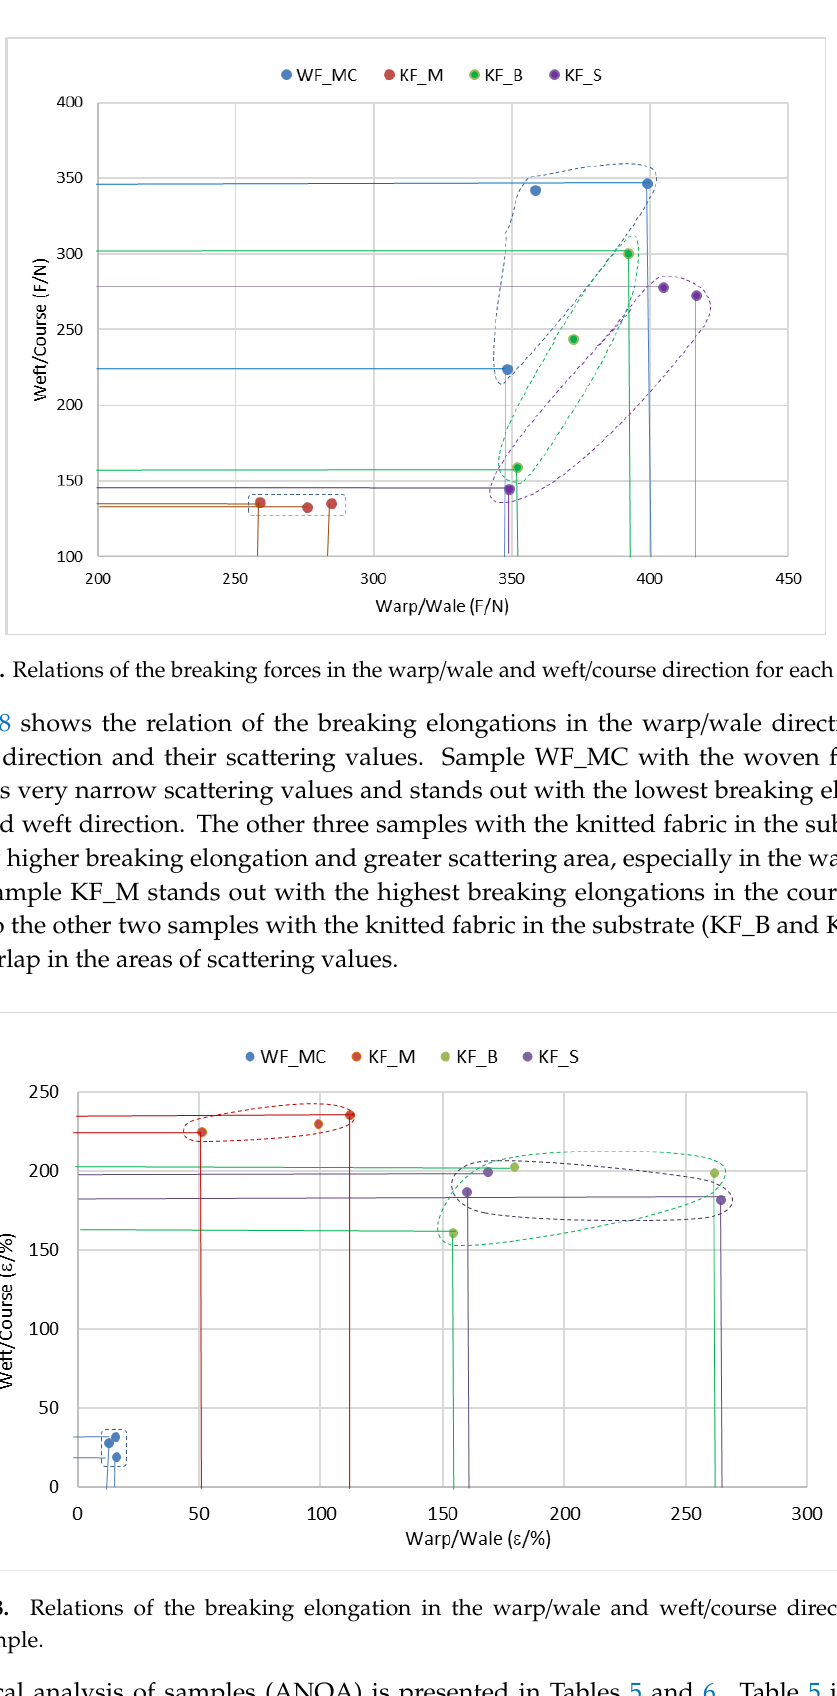
Table 5. Results of the ANOVA analysis for breaking force.